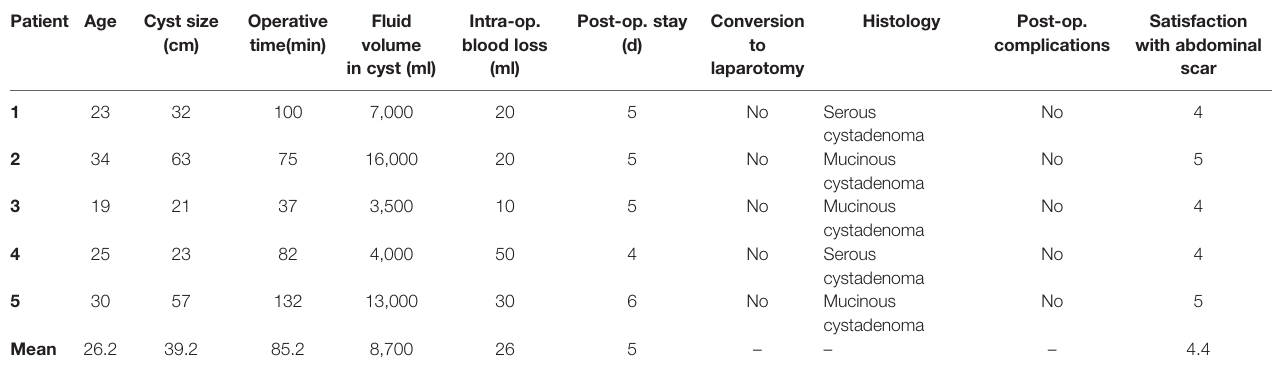
TABLE 2 | Surgical outcomes of the fi ve